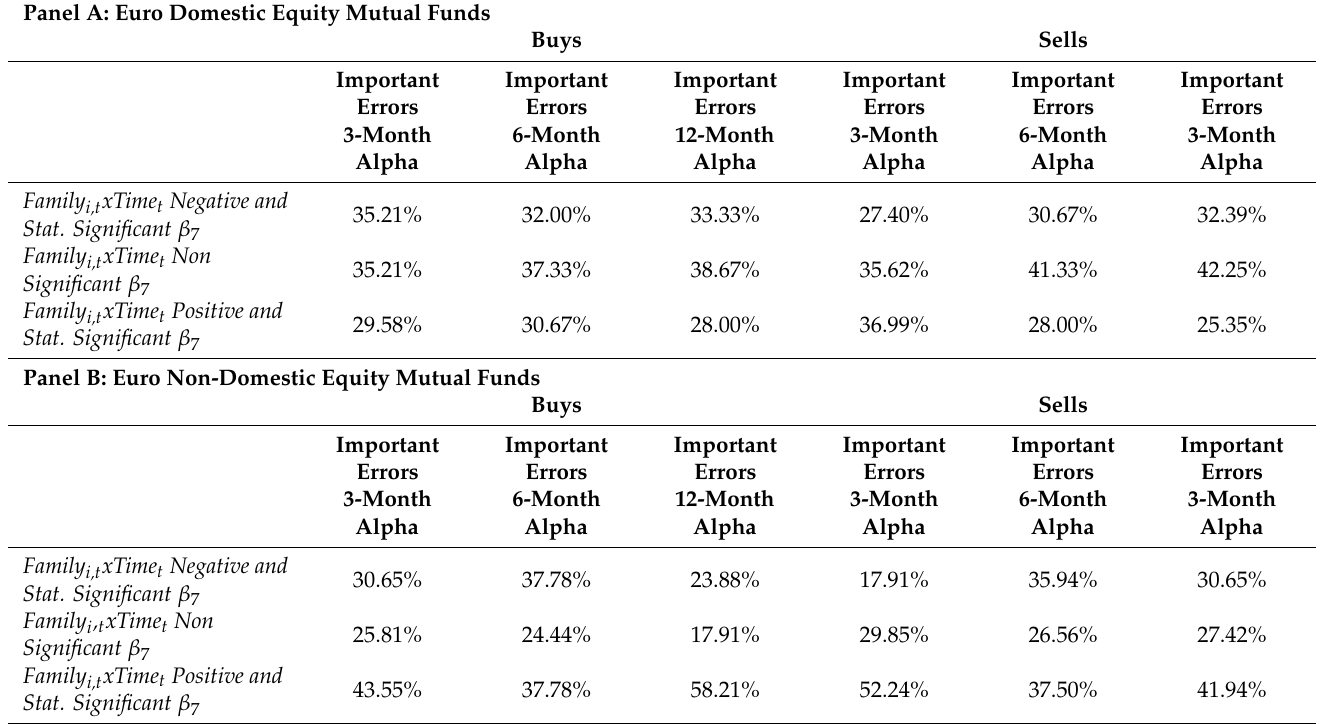
Table 5. Learning results: a fund family approach. This table presents the percentage of fund families based on both the sign and the significance of the slope of the interaction between the dummy variable Family i,t and Time t ( β 7 ) in Equation (15) for each fund family. Panel A has the results for families which manage Euro domestic equity funds, and Panel B has the results for families which manage Euro non-domestic equity mutual funds. Similar to Tables 3 and 4, the learning results are divided into buys and sells after considering different time horizons to compute the subsequent effect of these errors: 3-month alpha, 6-month alpha, and 12-month